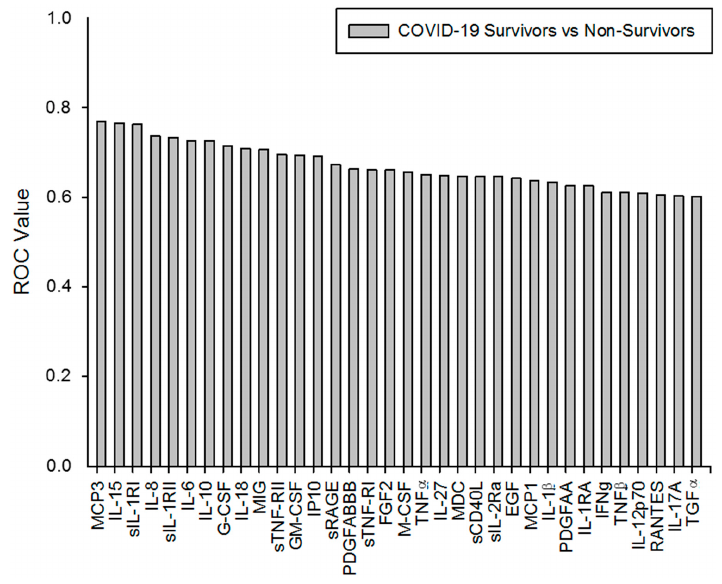
Figure 5. Adaptive cytokine results. ( A – C ) Data represent the concentrations of the cytokines and soluble receptors indicated for ( ) surviving COVID-19 patients, ( ) non-surviving COVID-19 patients and ( ) healthy controls. All the values are expressed as the means ± S.E.M.s *, p < 0.05 for surviving or non-surviving COVID-19 patients versus healthy controls. †, p < 0.05 for surviving versus non-surviving COVID-19 patients. ( D ) Data represent the ratios between circulating levels of surviving and non-surviving COVID-19 patients. The dotted line represents a reference line for the ratio equal to 1 between survivors and non-survivors